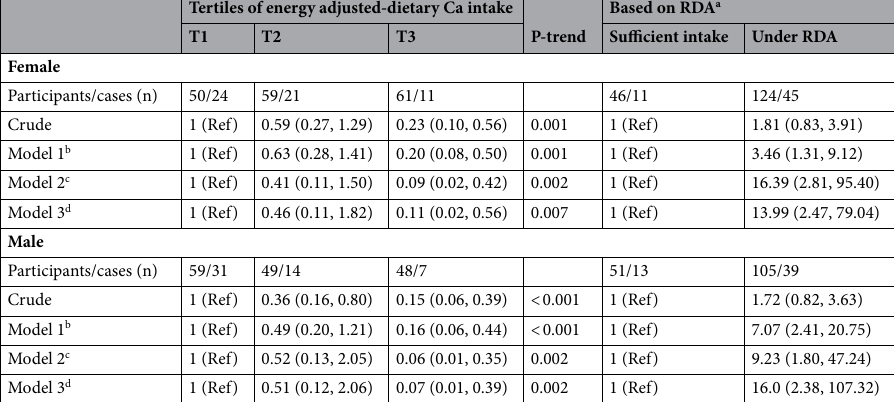
Table 4. Multivariable-adjusted odds ratio and 95% confidence intervals for ulcerative colitis (UC) across tertiles of energy adjusted-dietary Ca intake, stratified by gender. All values are odds ratios and 95% confidence intervals. a RDA: Recommended Dietary Allowances for dietary Ca intake (Man: ≥ 1000 mg; Women: 19–50 years: ≥ 1000 mg; ≥ 51 years: ≥ 1200 mg). b Model 1: Adjusted for age, and energy intake. c Model